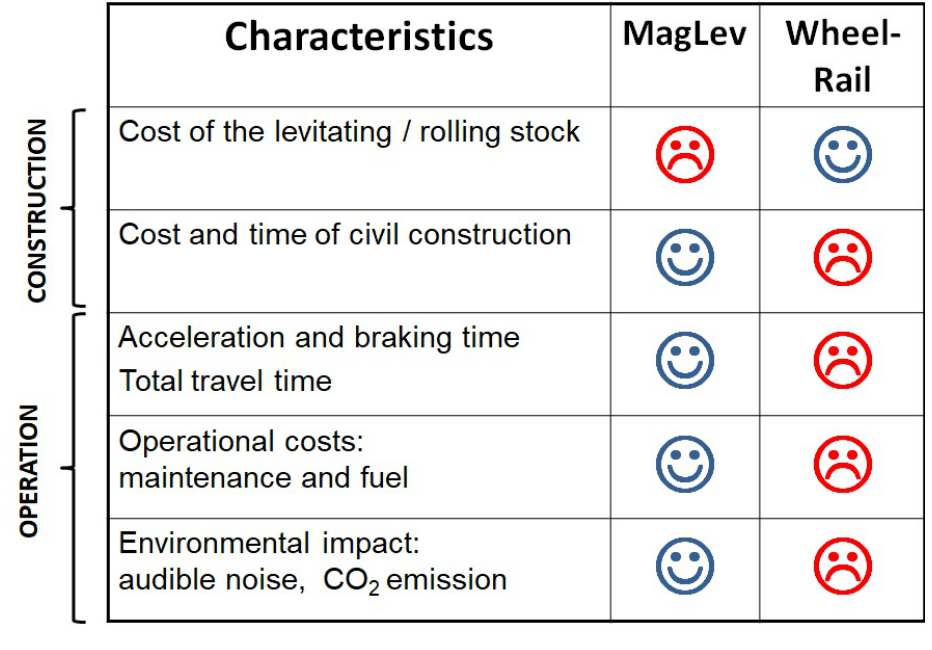
Figure 2. Comparison of MagLev x